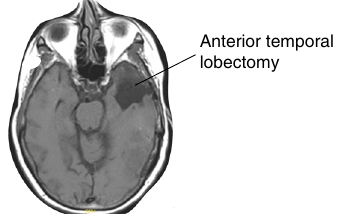
Fig. 8 Anterior left temporal lobe resection. A representative participant who had undergone extensive resection of the left anterior inferior, middle and superior temporal gyri, and which did not involve the